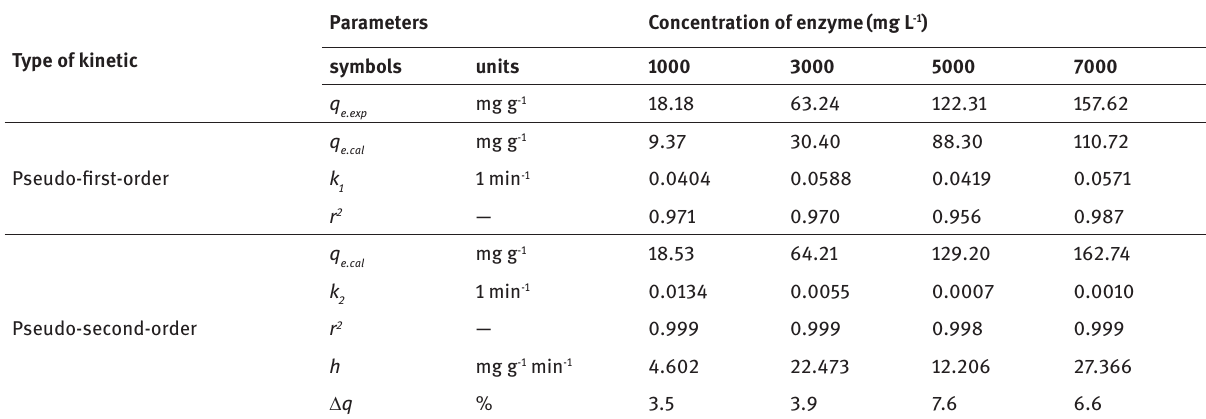
Table 5: Pseudo-first-order and pseudo-second-order kinetic parameters and the coefficient of determination for adsorption of enzyme onto